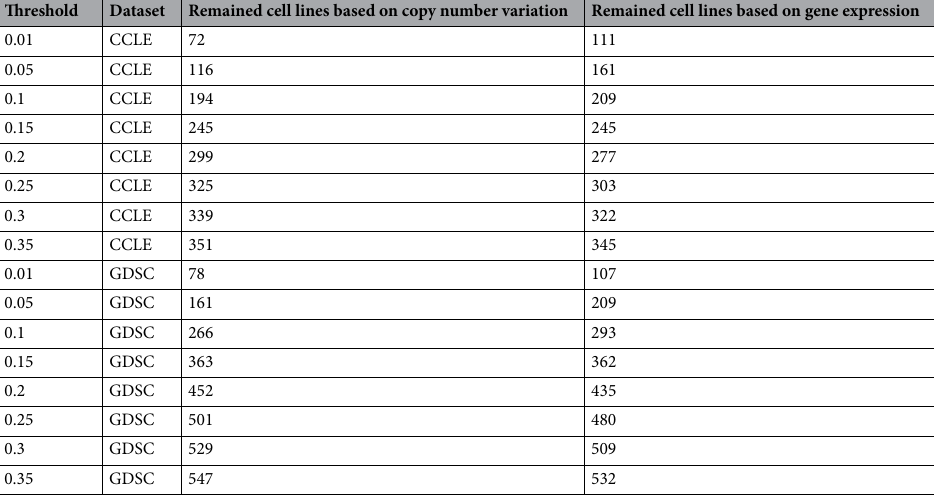
Threshold Dataset Remained cell lines based on copy number variation Remained cell lines based on gene expression